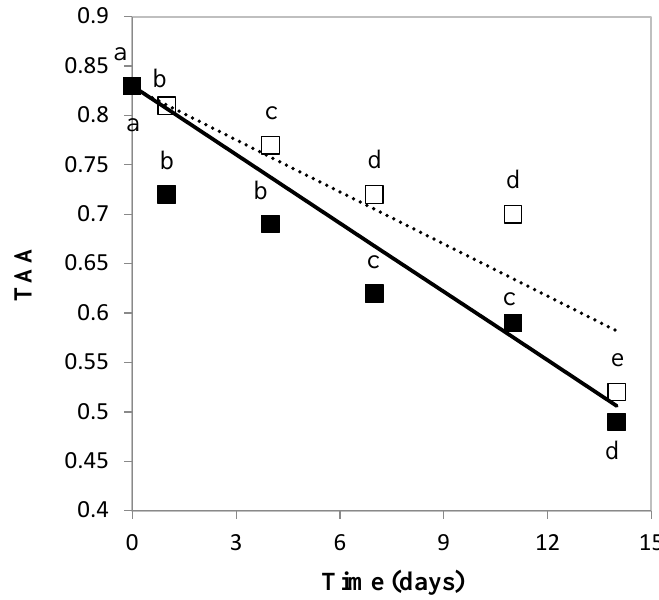
Figure 5. Antioxidant capacity as function of storage time for samples stored 14 days at 4 °C. Control sample ( ■ ); coated sample (□). Different letters correspond samples significant effect due to time effect.